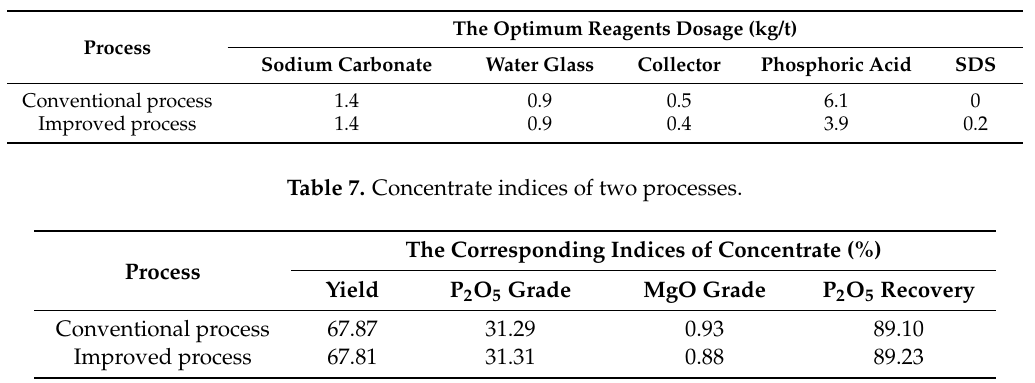
Table 6. Optimum reagent dosages of two processes.